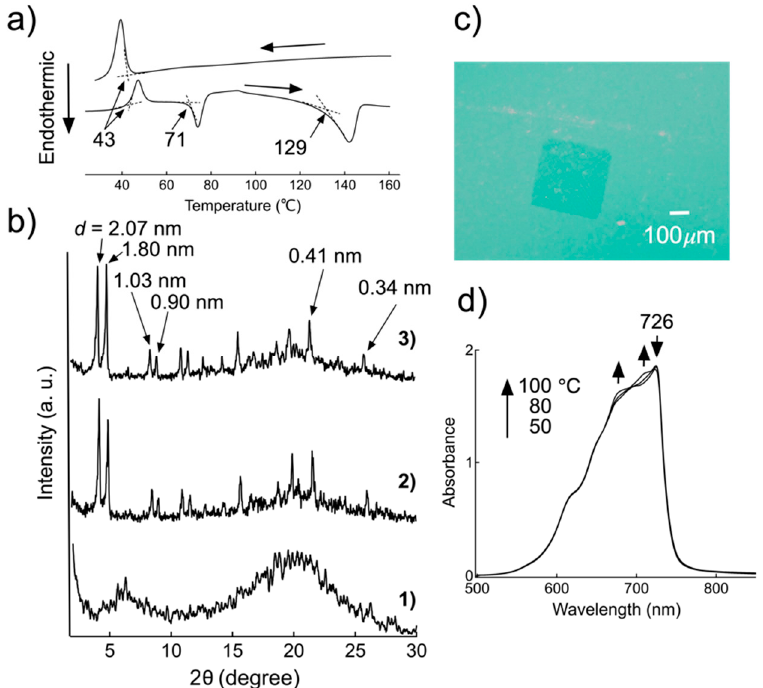
Figure 9. ( a ) DSC thermogram of 2 film during the first cooling and the second heating scans at 20 ◦ C / min. ( b ) XRD pattern of 2 film at the first cooling run at 45 ◦ C ( 1 ), the second heating run at 60 ( 2 ) and 100 ◦ C ( 3 ) at 20 ◦ C / min. ( c ) optical image of 2 at 60 ◦ C. ( d ) Absorption spectrum of 2 film during the second heating run at 50, 80, and 100 ◦ C.